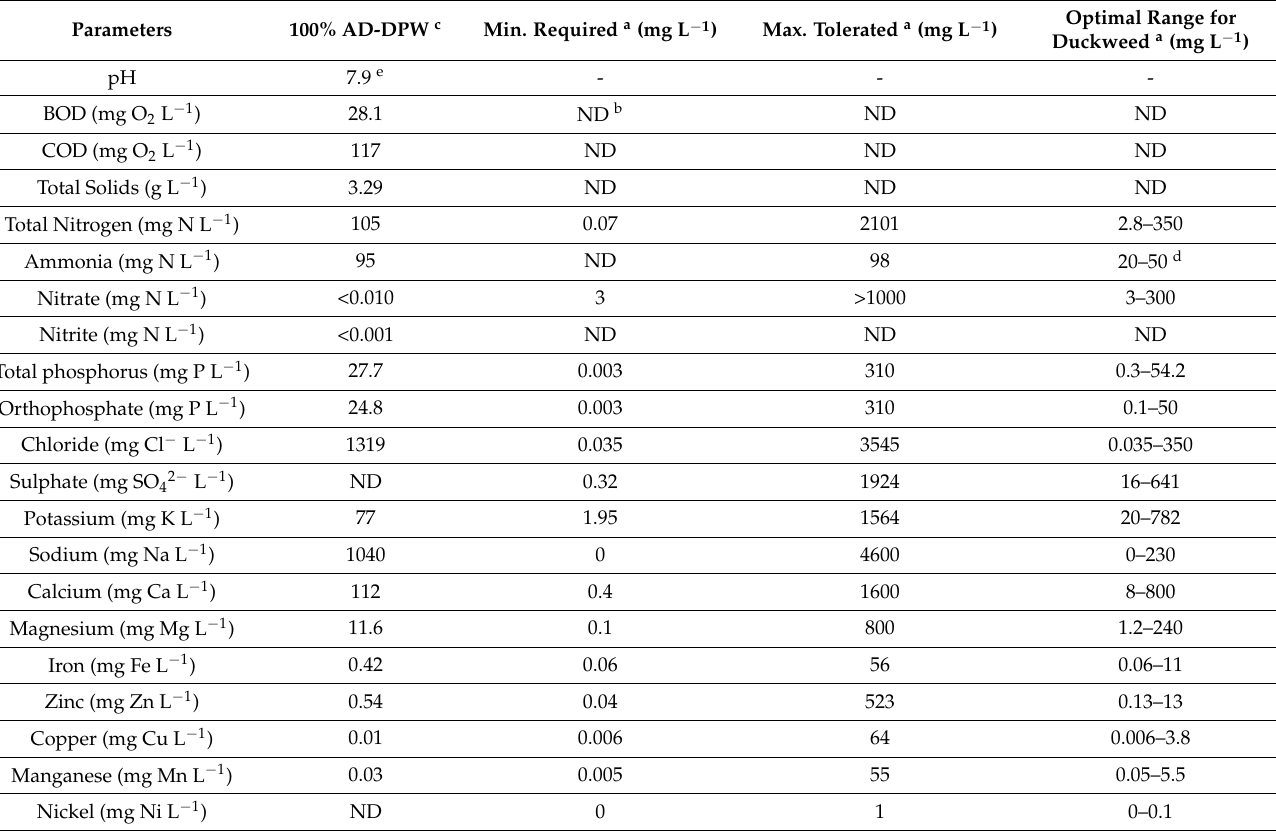
Table 1. Concentration of compounds and elements present in AD-DPW c , along with duckweed’s required, tolerated, and optimal